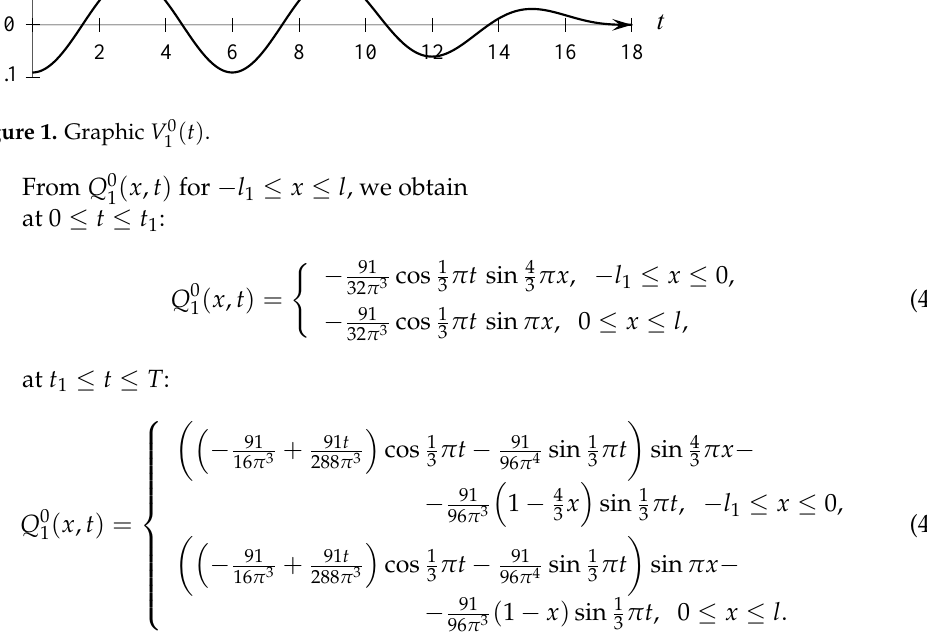
Figure 1. Graphic V 0